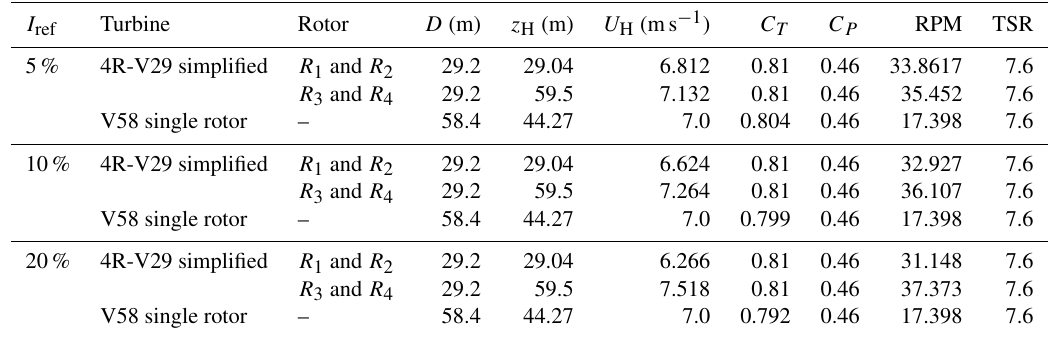
Table 2. Definition of the simplified 4R-V29 multi-rotor wind turbine and an equivalent V58 single-rotor wind turbine for three ambient turbulence